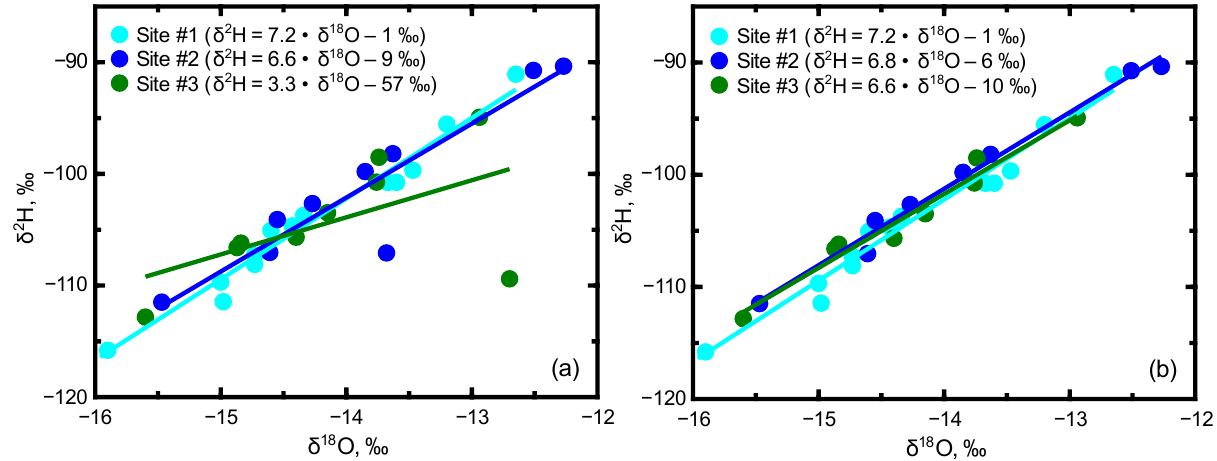
Figure 3. Distribution of δ 2 H ( a ) and δ 18 O ( b ) for snowpack (Sn), snowmelt (Mlt), and ephemeral creeks (Crk) in the study area. Boxplots indicate the median, mean ( □ ), interquartile range (25% to 75%), and whisker range of 5% to 95% along with outliers (×). An examination of the snowpack composite δ 2 H and δ 18 O values collected from each site indicate a relatively similar grouping along a meteoric water line (Figure 4). Individual trendlines for Site #2 and Site #3 indicate a decrease in slope compared to Site #1, primarily because of outliers at Site #2 and Site #3. These outliers were collected during the same sample period in late March and do not appear to be reflective of the local meteoric water lines for the snowpack at these sites. Removal of these two outliers results in trendlines of similar slope for all three sites (7.2, 6.8, and 6.6, respectively for Sites #1–3), although there are slightly lower slopes for lower elevation sites. This decreasing slope with elevation is reflective of greater evaporation given warmer temperatures at the lower elevations. The range of δ 2 H and δ 18 O values of the composite snowpack samples corresponds to predicted values of Bowen [65] for northern Idaho, although the snowpack did not contain the strongly depleted winter values (e.g., δ 18 O values < − 20‰) of Bowen’s isoscapes.